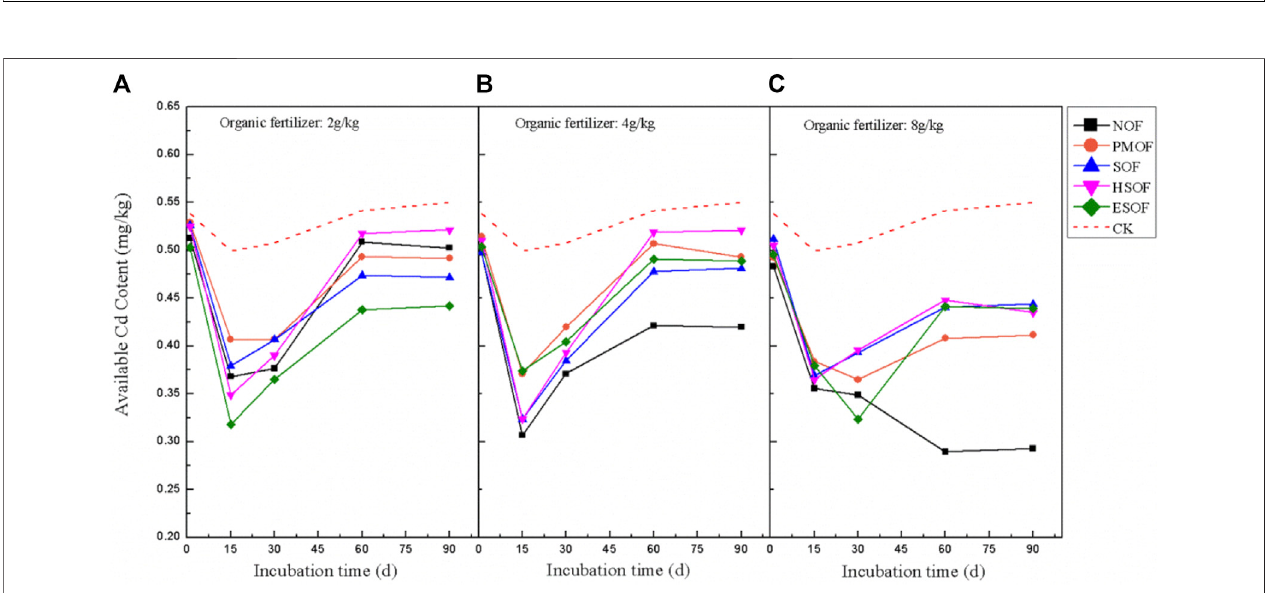
FIGURE 3 | Changes in available Cd content in soil treated with different dosages of organic fertilizers over time ( (A) : OF = 2 g/kg; (B) : OF = 4 g/kg; (C) : OF = 8 g/kg).